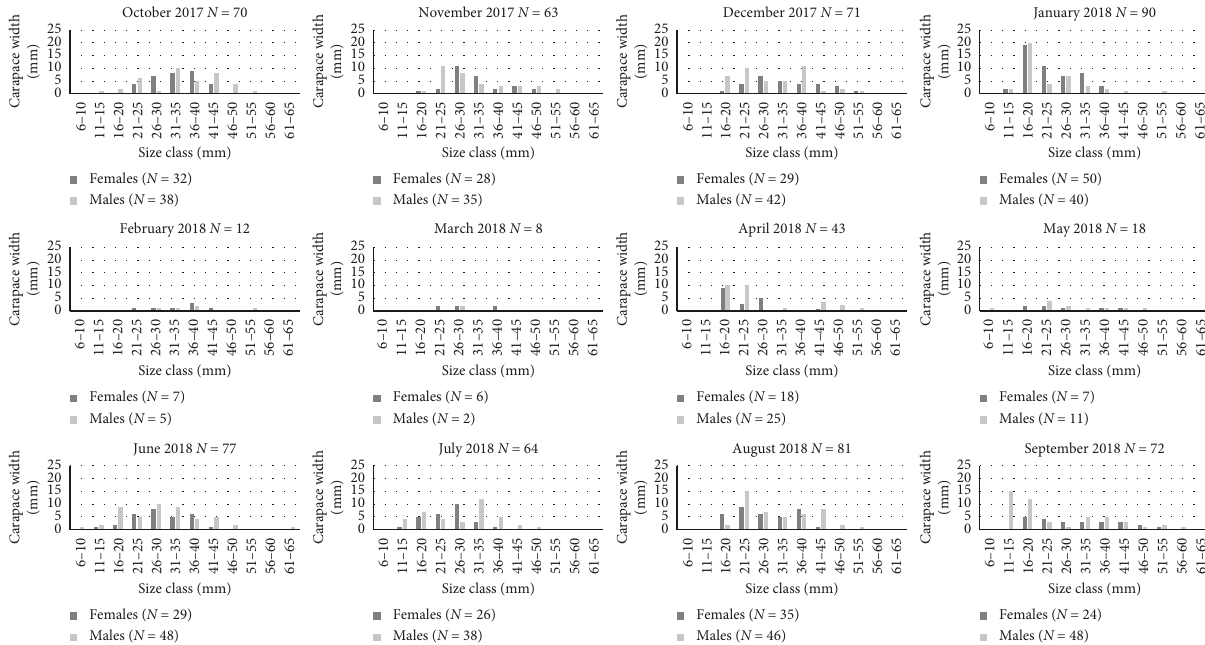
Figure 6: Monthly specimen’s distributions of males and females by size class of Potamon algeriense from Oued